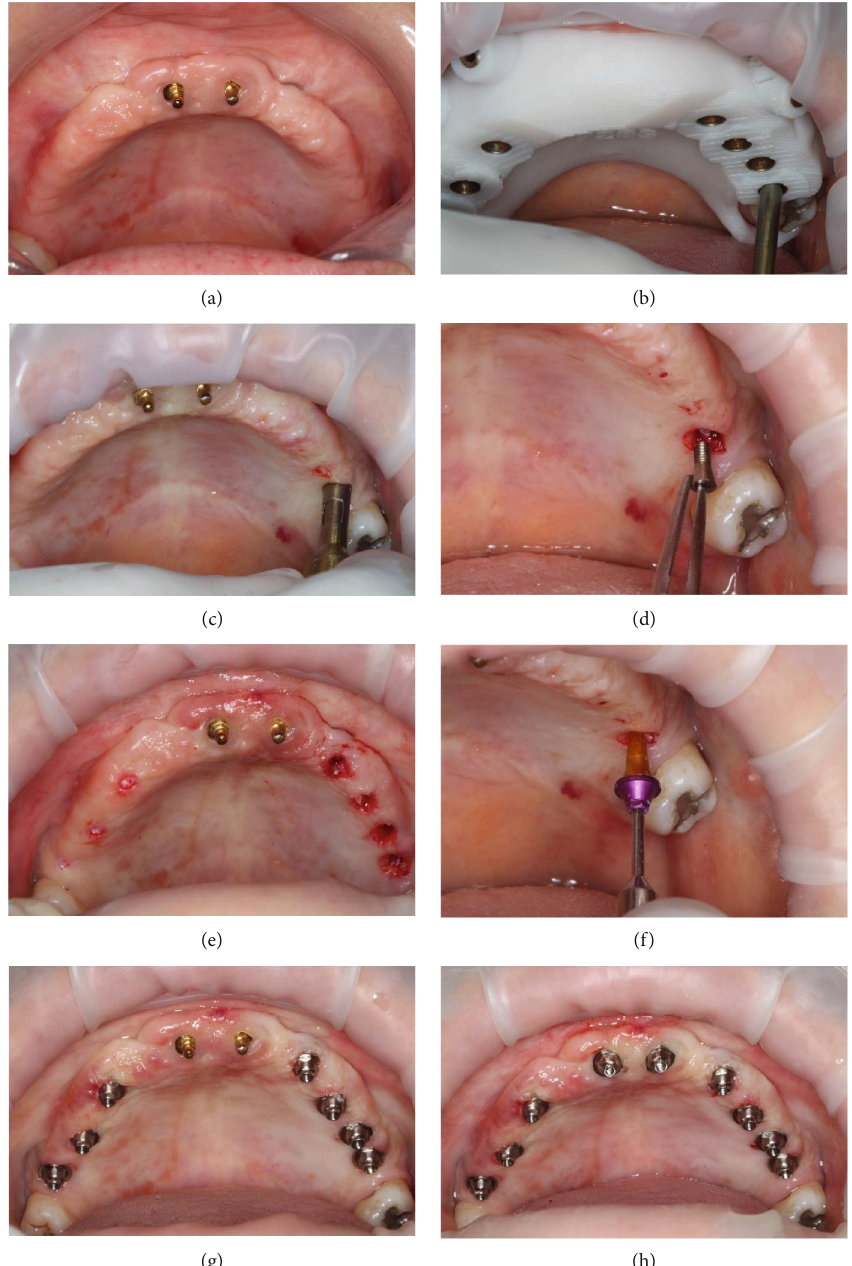
Figure 8: The implants were allowed to heal for 4 months, and then, the procedures to expose the implants were initiated (a, b). The cover screws of all implants were removed with the aid of the surgical template (c – f). Appropriate abutments were chosen and installed (g,